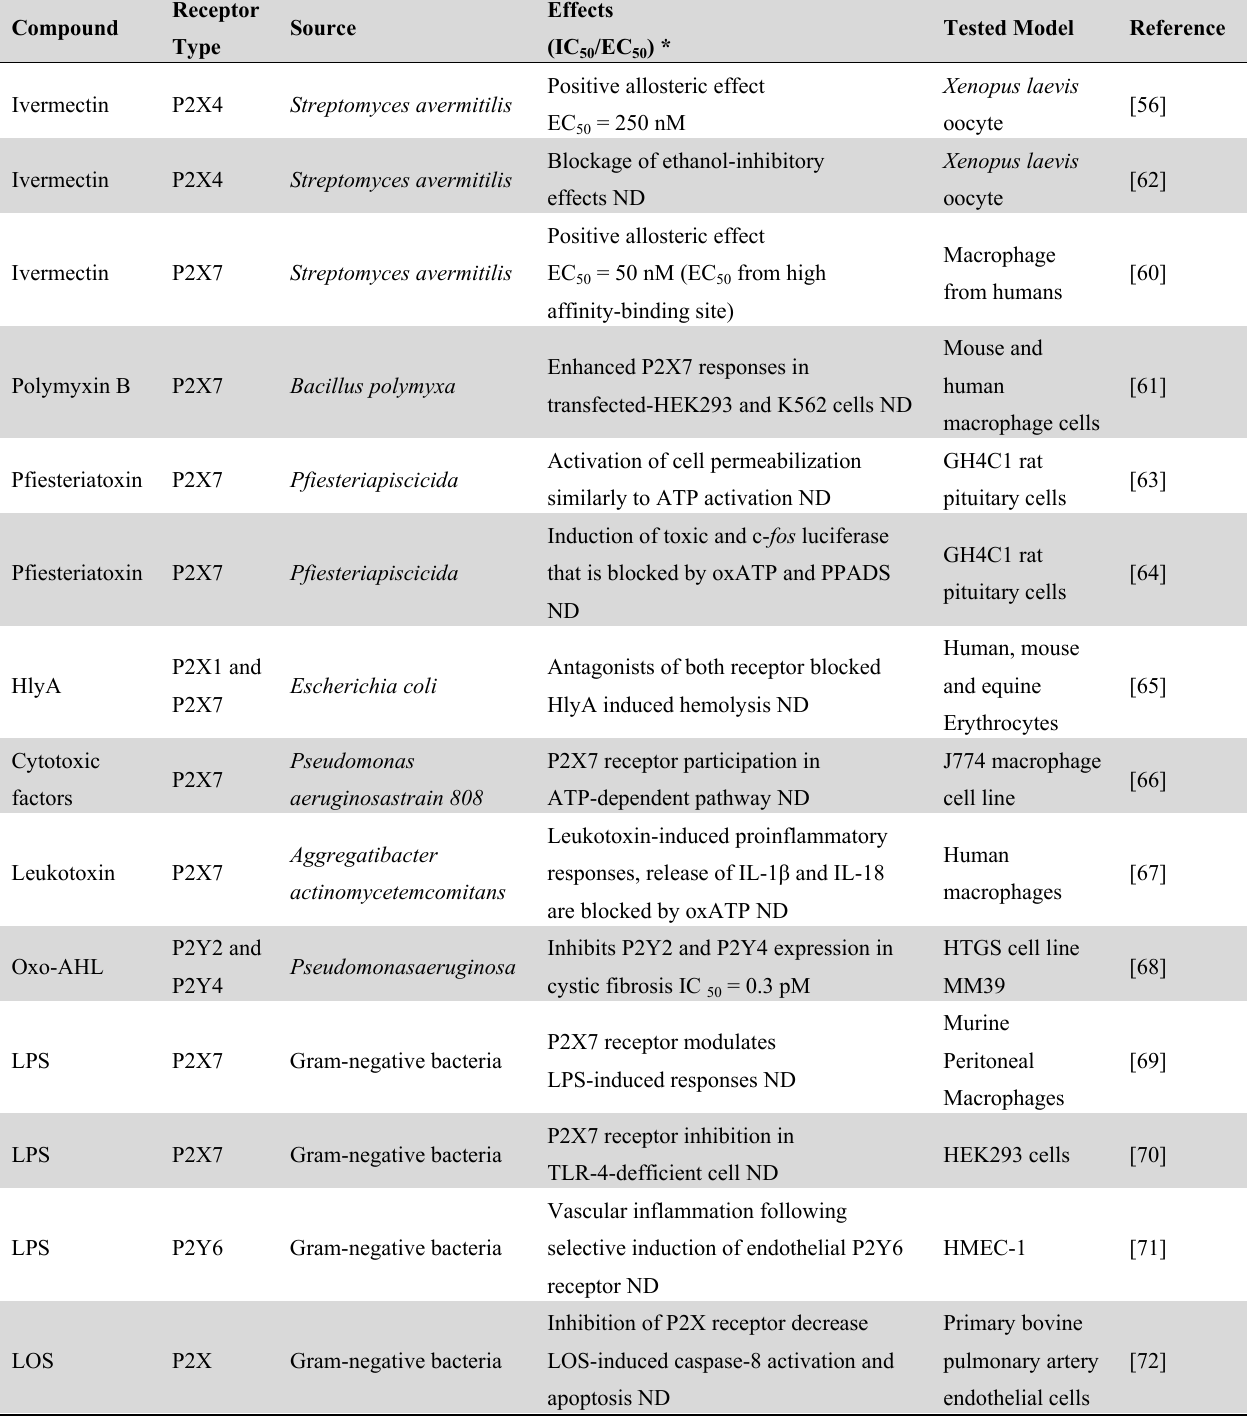
* EC = half maximal effective concentration; IC 50 ND = Not Determinated; LOS =